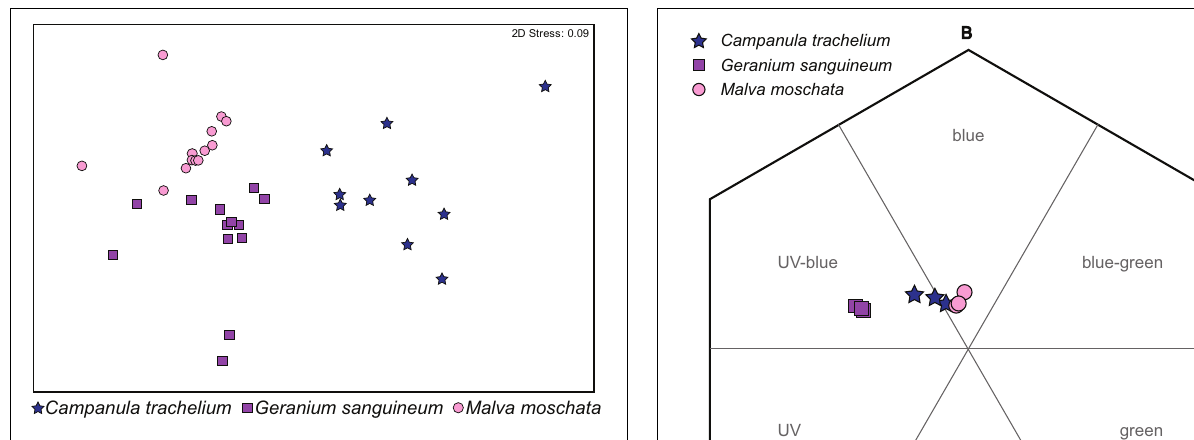
FIGURE 5 | Non-metric multidimensional scaling based on the Bray-Curtis similarities of the semi-quantitative amounts of EAD-active compounds identified in headspace samples from C. trachelium ( N = 10), G. sanguineum ( N = 13), and M. moschata ( N = 13) inflorescences (ANOSIM R = 0.65, P < 0.001).